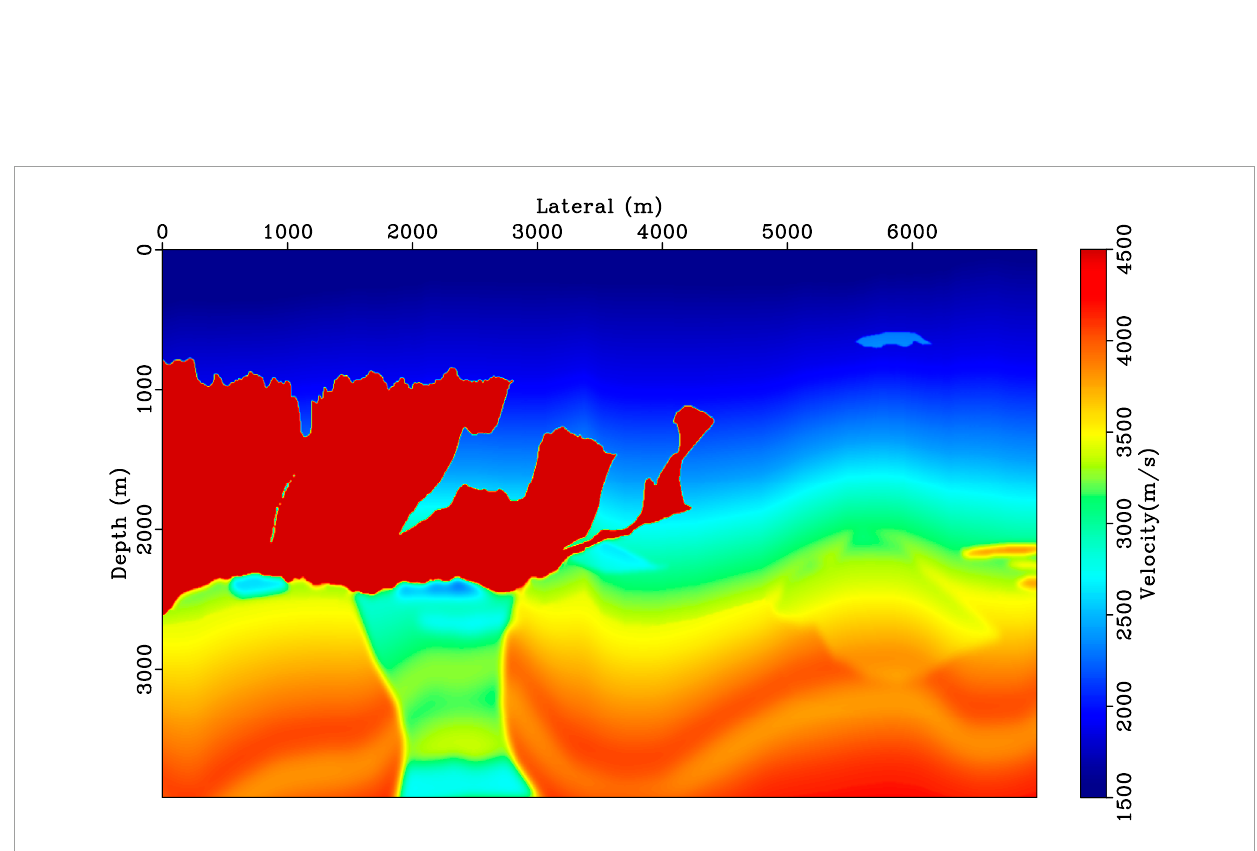
FIGURE 9 BP model with 560×1000 grid nodes and grid spacing h = 7.5 m , the variation of velocities from 1500 m / s to 4500 m / s